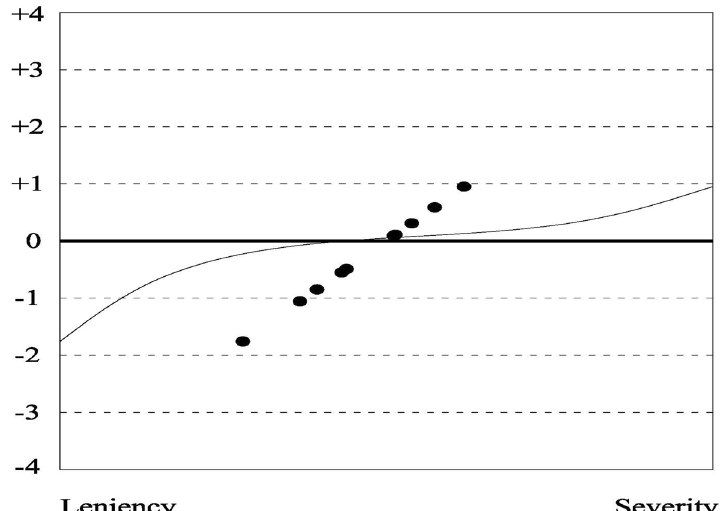
Fig. 7 New raters’ bias interaction (immediate